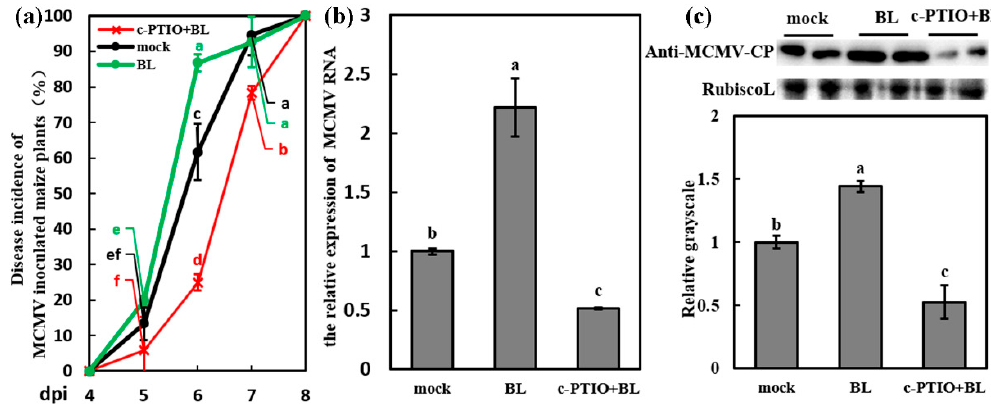
Figure 6. BR mediated the susceptibility to MCMV in a NO-dependent manner. ( a ) Disease incidence (%) of MCMV-inoculated maize plants after application of Tween-20 (0.02%, mock), BL (500 µ M), and c-PTIO + BL (a mixture of 200 µ M c-PTIO and 500 µ M BL) with three independent replicates. Significant di ff erences of disease incidence between di ff erent treatments (mock, BL and c-PTIO + BL) in the same dpi were indicated in lowercase letters. ( b ) RT-qPCR analysis of the MCMV RNA accumulation after application of Tween-20 (0.02%, mock), BL (500 µ M), and c-PTIO + BL (200 µ M c-PTIO and 500 µ M BL). ( c ) Representative western blot showing MCMV accumulation after application of Tween-20 (0.02%, mock), BL (500 µ M), and c-PTIO + BL (200 µ M c-PTIO and 500 µ M BL). The grayscales of immunoblotting bands were determined by ImageJ. Graphs represent the relative MCMV accumulation through quantifications of three independent experiments with at least three plants per experiment. Statistical analysis was performed using SPSS 16.0 followed by ANOVA with LSD test at the level of p -value ≤ 0.05. Significant difference between different samples was indicated in lowercase letters.